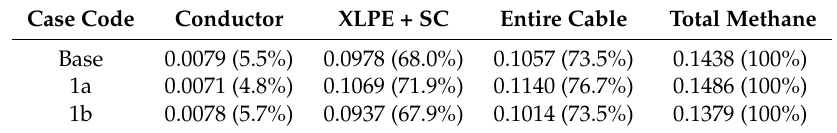
Table 6. Amount of CH 4 (mol/m) present in each cable component at the cable take-up